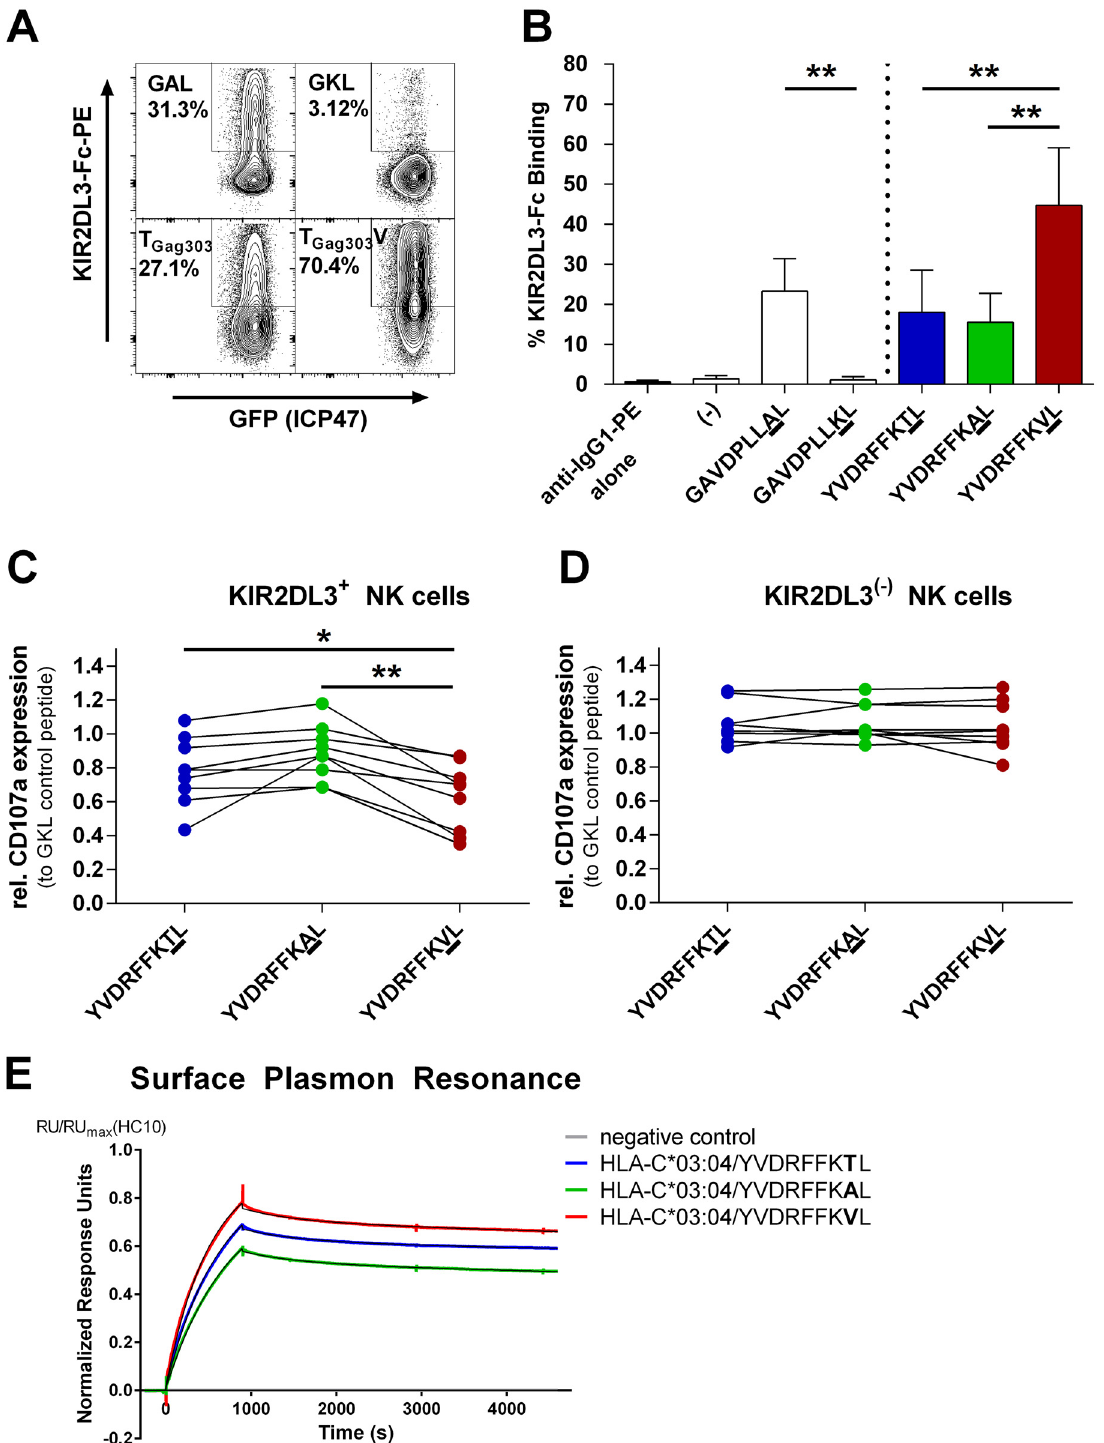
Fig 3. Binding of KIR2DL3-Fc and inhibition of primary KIR2DL3+ NK cells is significantly stronger when target cells are pulsed with the T Gag303 V variant peptide. (A) Representative dot plots of KIR2DL3-Fc staining of 721.221-ICP47-C * 03:04 cells pulsed with positive control peptide GAL, negative control peptide GKL, T Gag303 wild-type peptide, or T Gag303 V variant peptide. Staining was measured by flow cytometry after addition of a secondary PE- conjugated anti-IgG antibody. All cells express GFP, indicating successful transduction of ICP47 and thus optimal blockade of TAP. (B) Quantification of KIR2DL3 binding expressed as percent of cells binding KIR2DL3-Fc. Means of six independent experiments, with error bars representing SD, are shown.